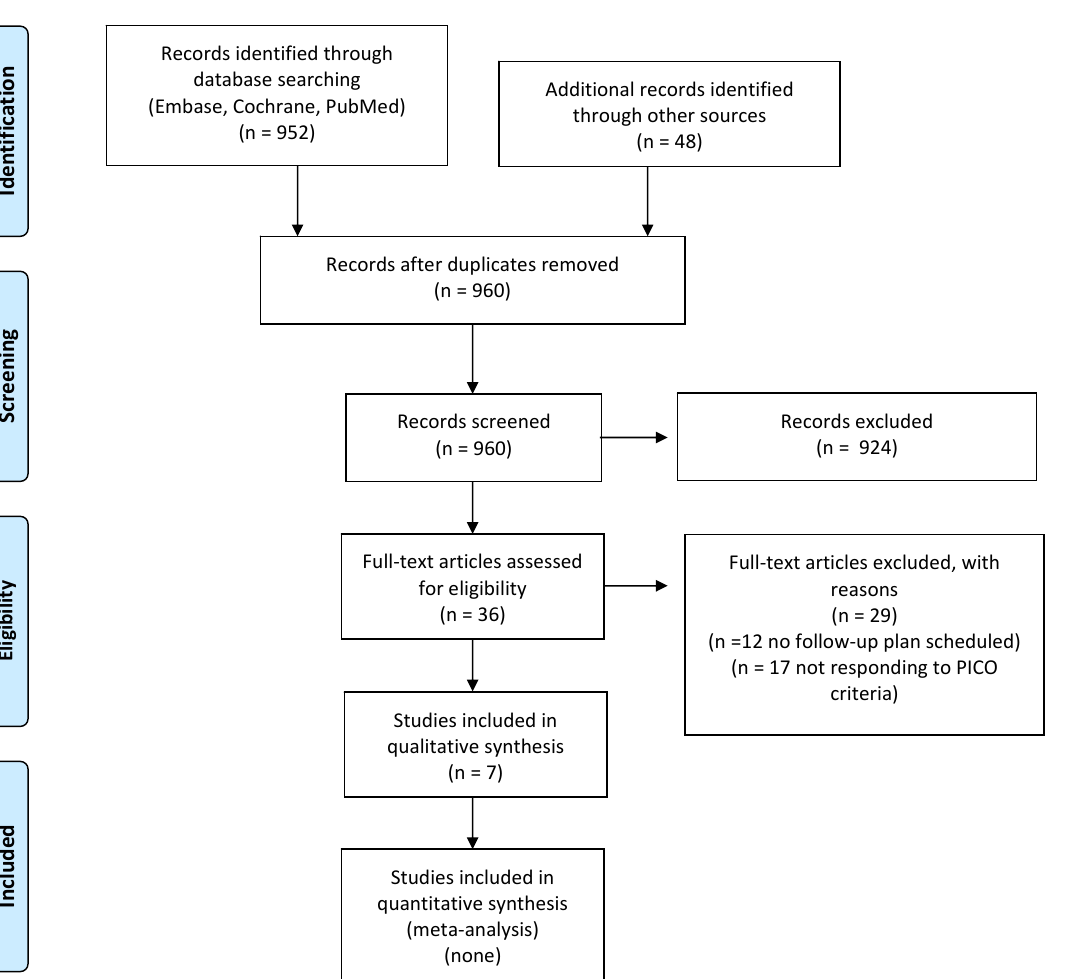
Figure 3. PICO C: PRISMA flow-chart for planned follow-up/screening schemes for the management and early diagnosis of second